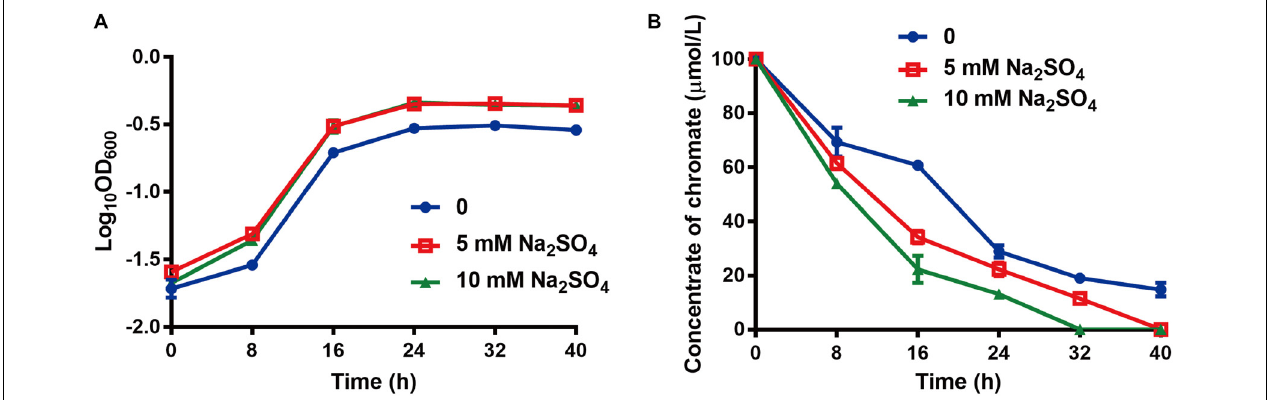
FIGURE 4 | Effects of sulfate on chromate resistance and reduction. (A) The growth curve of strain WH16-1 with various amounts of additional sulfate in CDM medium. (B) The chromate reduction curve of strain WH16-1 with various additional Na 2 SO 4 . Data are shown as the mean of three biological replicates ±